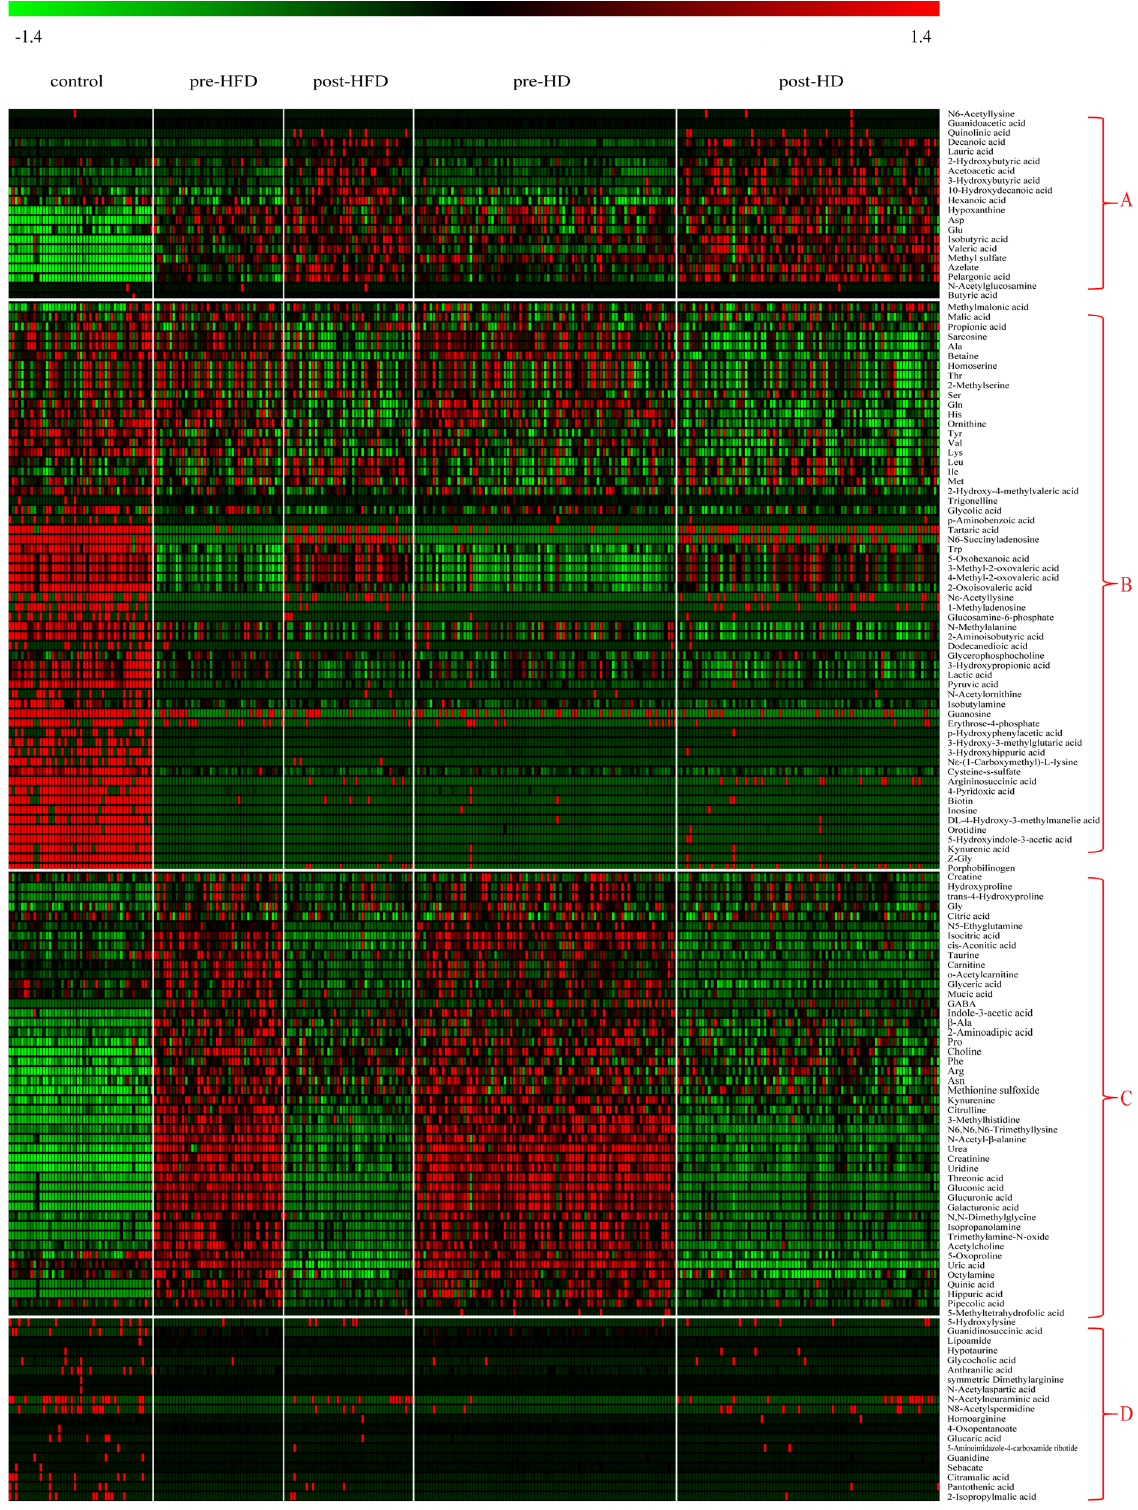
Figure 2. Heat maps of 144 plasma metabolites in five groups. Red, green and black indicate high, low and unchanged levels of metabolites,